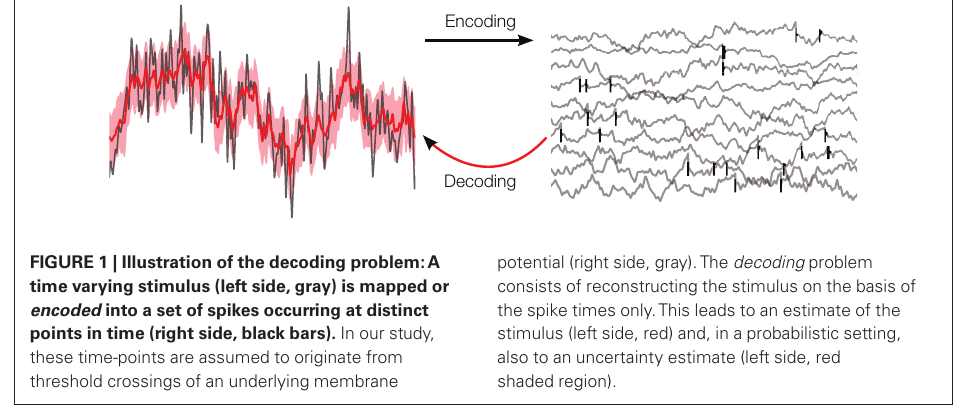
potential (right side, gray). The decoding problem consists of reconstructing the stimulus on the basis of the spike times only. This leads to an estimate of the stimulus (left side, red) and, in a probabilistic setting, also to an uncertainty estimate (left side, red shaded